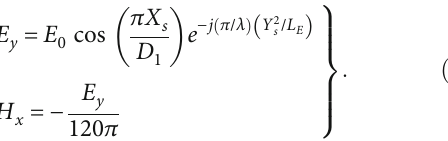
Figure 2: An oblique horn antenna.